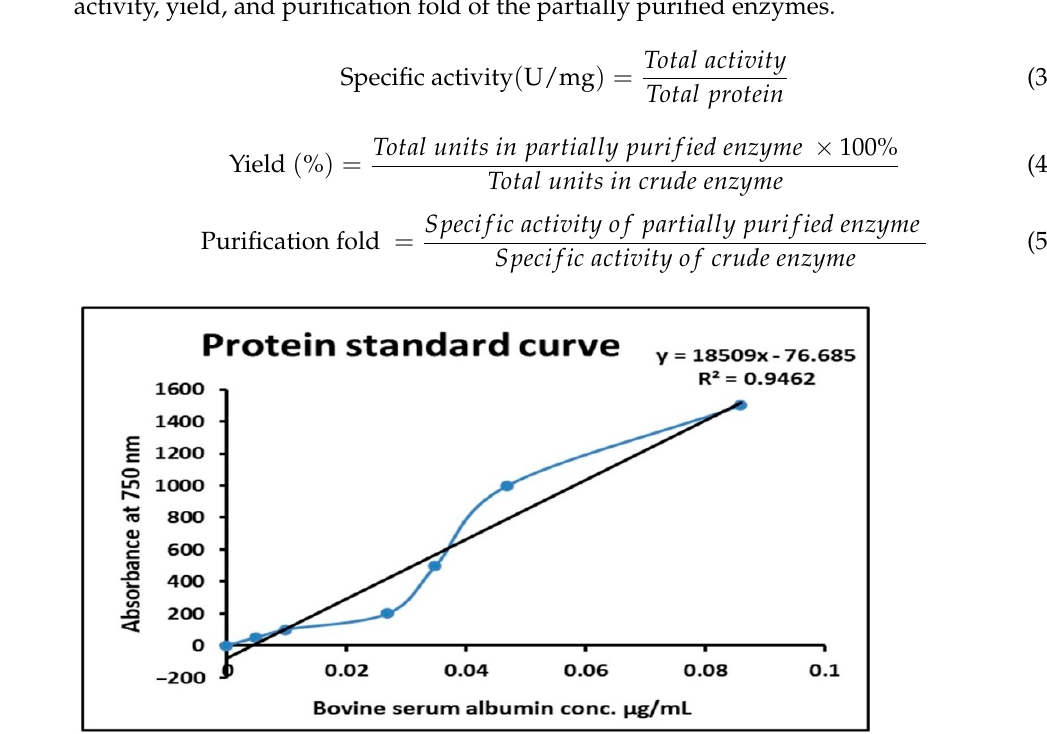
Figure 2. Protein standard